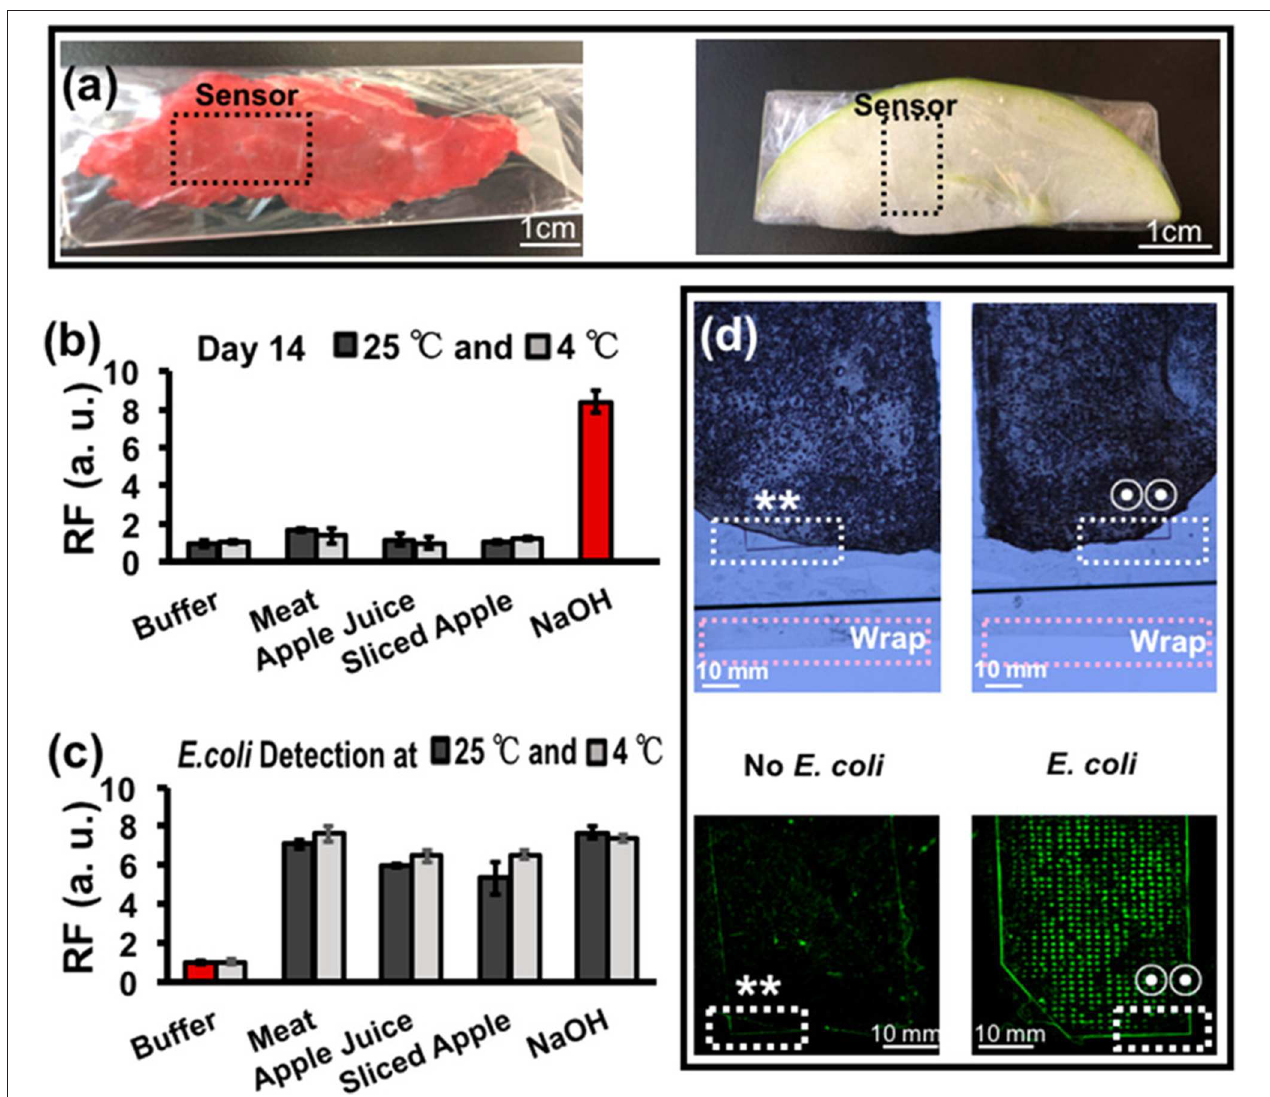
FIGURE 11 | Detection of bacteria in food by RNA-cleaving DNAzyme (RFD-EC1) reactive sentinel wraps. (a) Meat and apple samples were wrapped in the RFD-EC1 incorporated polymer wraps. The RFD-EC1 were incubated in buffer, meat, apple juice sliced apple or NaOH either without (b) or with (c) bacteria present for 14 days. A clear fluorescence signal was generated by RFD-EC1 in the presence of E. coli (d) . Likewise, the RFD-EC1 incorporated food wrap revealed distinct fluorescence when the food samples had been inoculated with a bacteria mixture with and without E. coli . Overlapping regions in the bright field (top) and fluorescence (bottom) are represented by ** (no E. coli ) and two-circle symbol ( E. coli ). Reprinted (adapted) with permission from Yousefi et al. (2018). Copyright (2018) American Chemical Society. Permission has been obtained from American Chemical